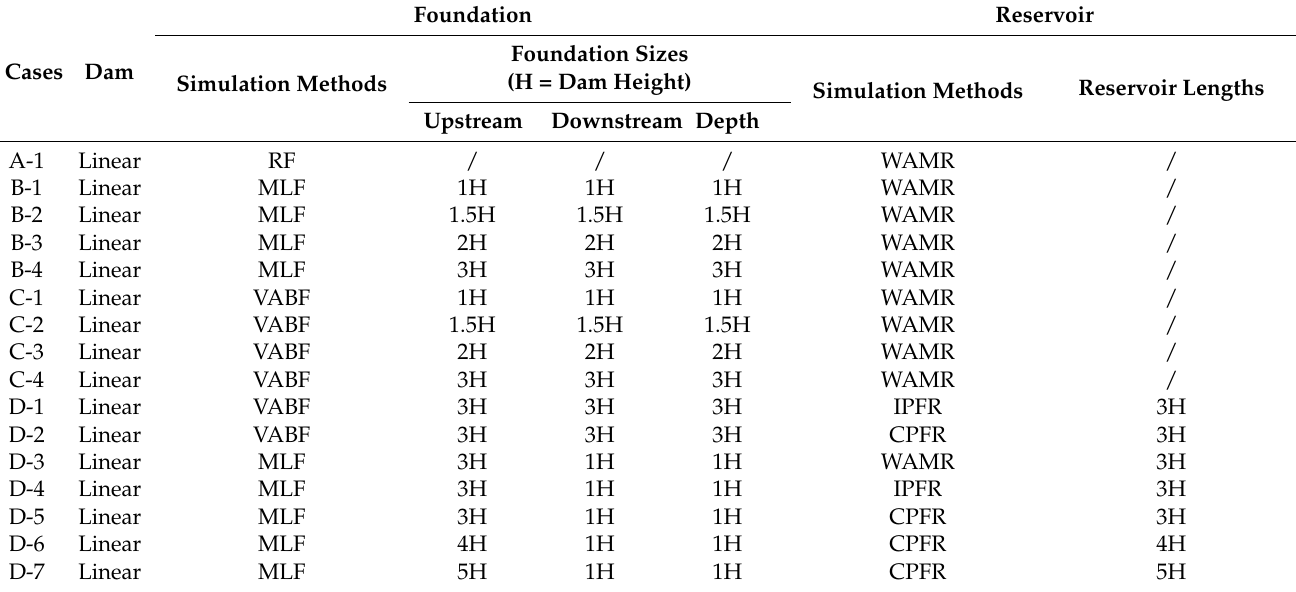
Table 1. Summary of models used for all